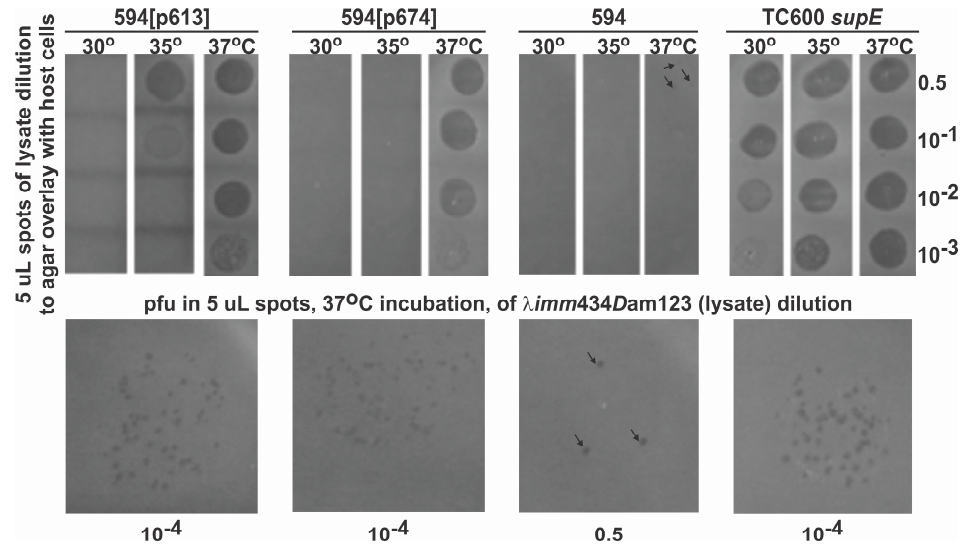
Figure 4. Plating of λ imm 434 D am123 spotted on overlaid host cells incubated at 30, 35 and 37 °C. Top panel: Representative ability of four host cells to support phage plating (indicated by lysis areas) at